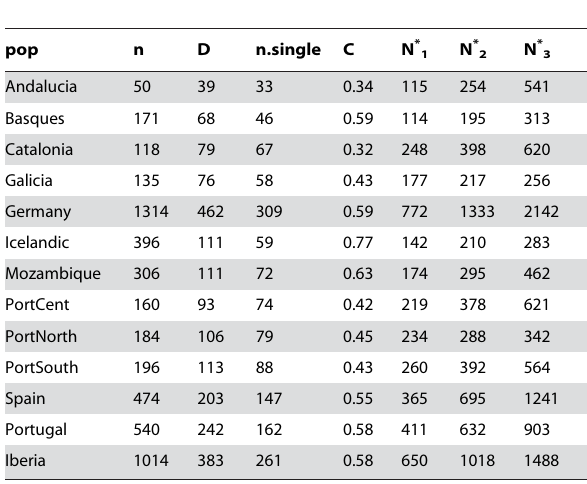
Table 3. Haplotype estimates from several population datasets.